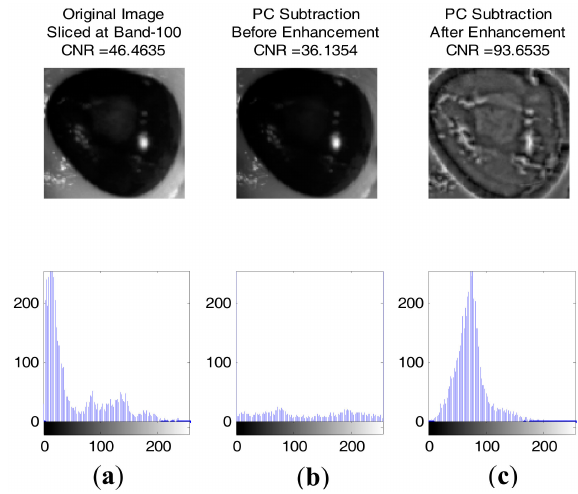
Figure 18. Image of injured cornea with the histogram underneath respectively. Images were normalised and resized to 100by 100: ( a ) OriginalImage sliced atband-100 (CNR: 46.4635); ( b ) Imageafter PC subtraction before enhancement (CNR: 36.1354); ( c ) Image after PC subtraction and enhancement (CNR: